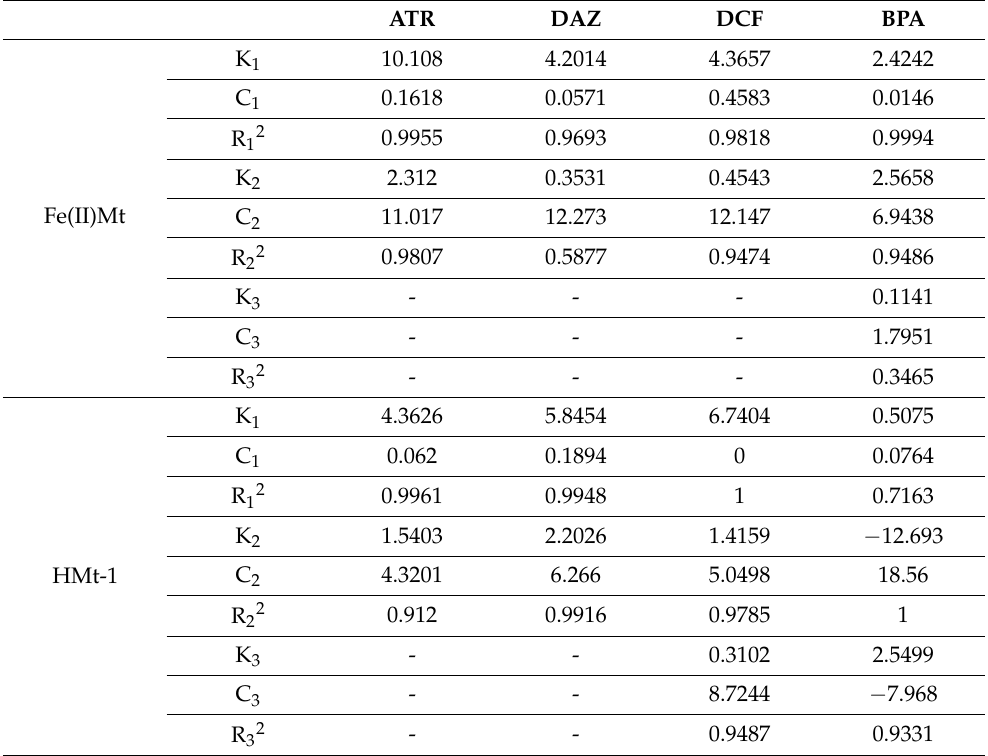
Table 3. Kinetic parameters of the intra-particle diffusion model for the adsorption of the organic substrate on Fe(II)Mt and